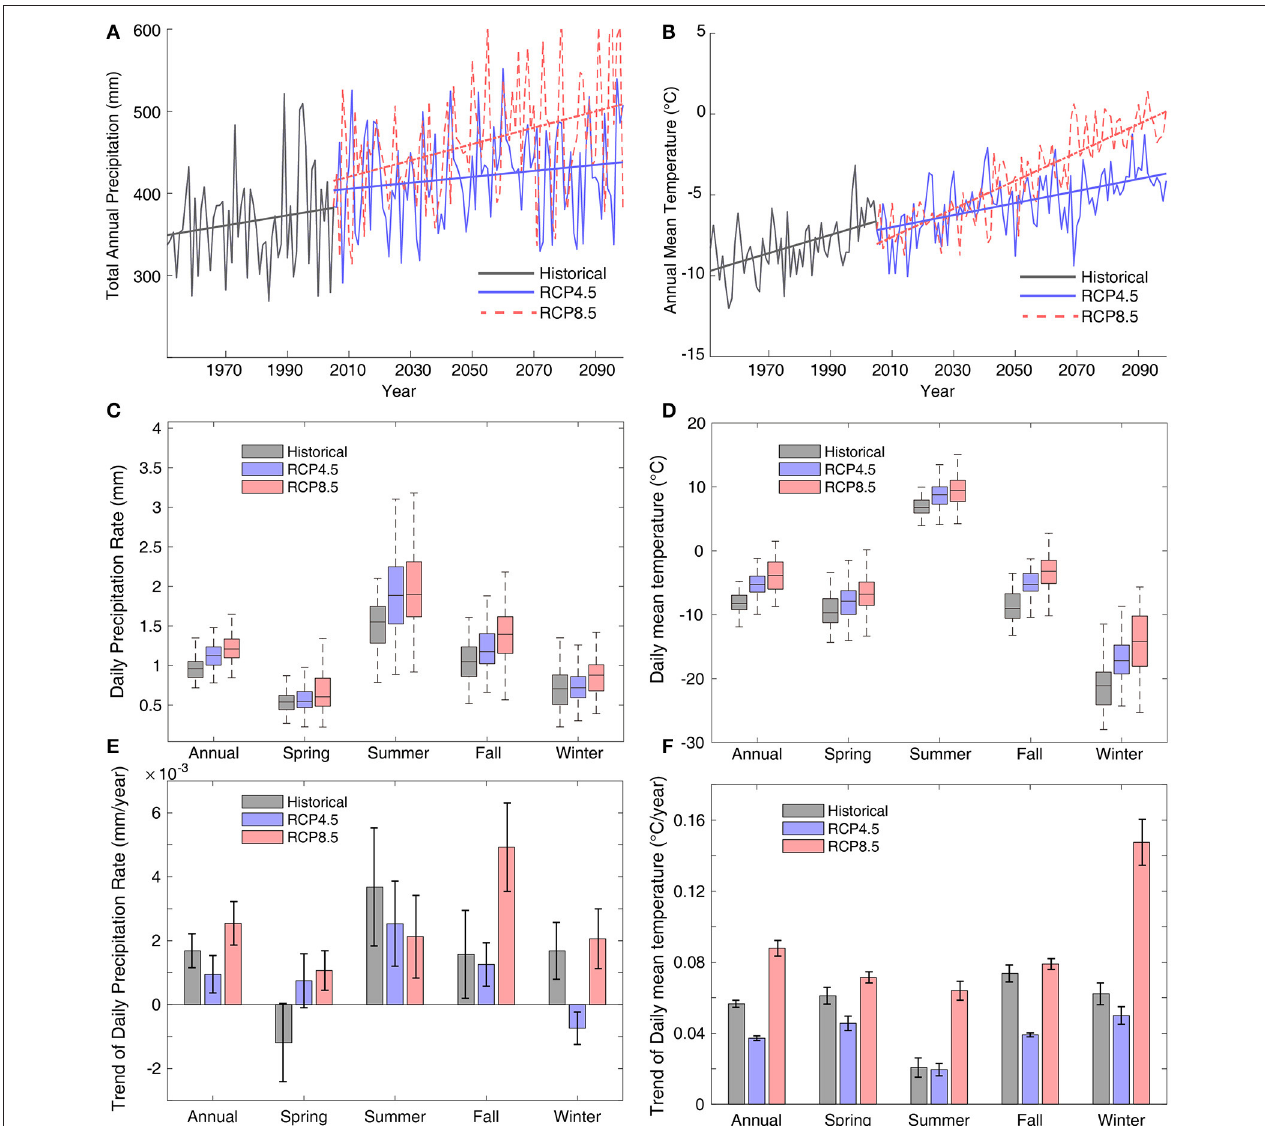
FIGURE 7 | The time series of (A) total annual precipitation and (B) annual mean air temperature. Represented are the historical (gray), RCP4.5 (blue), and RCP8.5 (red) downscaling products. Box plots show the annual and seasonal (C) daily precipitation rate (mm) and (D) daily mean air temperature ( ◦ C) from the three downscaling products, annual and seasonal trends of (E) daily precipitation rate (mm/year), and (F) daily mean temperature ( ◦